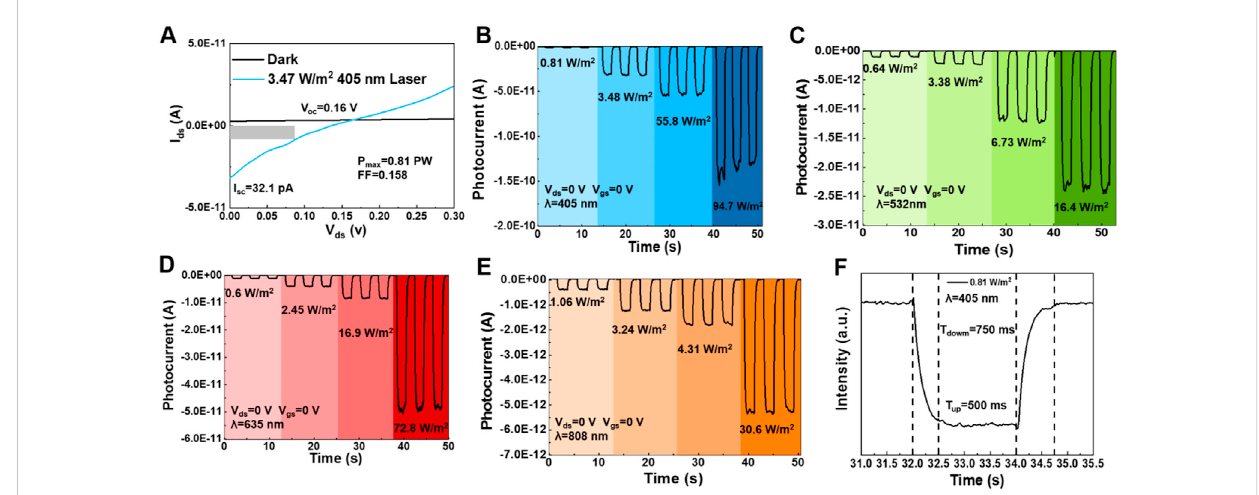
FIGURE 5 (A) I ds - V ds curve at zero bias, under dark and 405 nm laser irradiation, respectively. The photocurrent at different optical power intensities in response to (B) 405 nm, (C) 532 nm, (D) 635 nm and (E) 808 nm lasers, respectively. (F) Rise and fall time of the MnSe/WSe 2 heterojunction device under zero bias and 405 nm laser